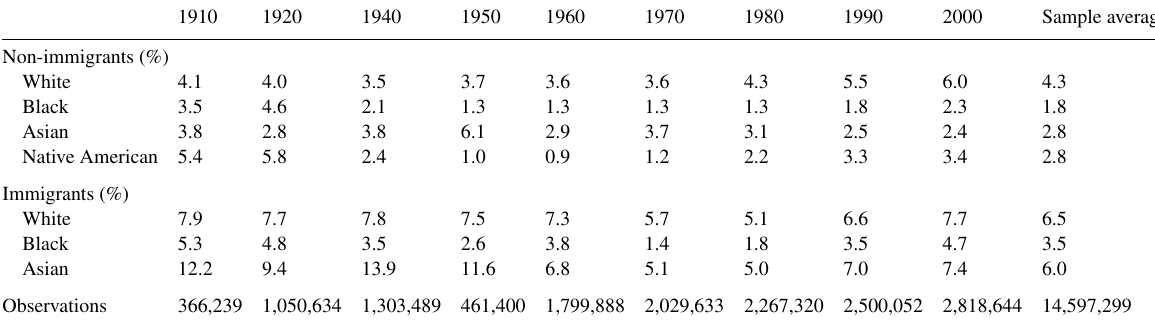
Table 7 U.S. self-employment rates: